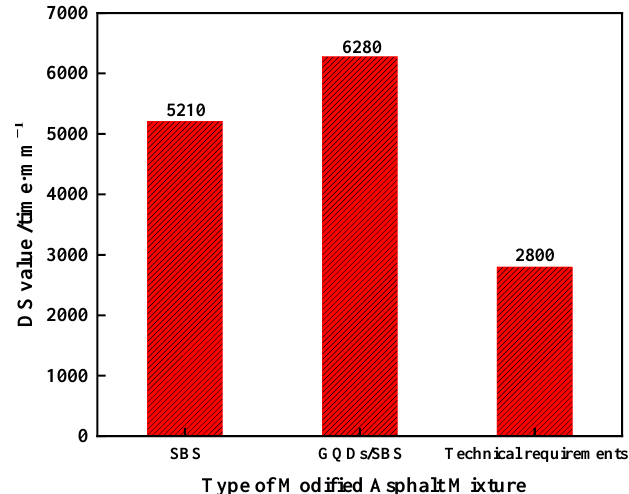
Figure 15. Results of wheel tracking test.